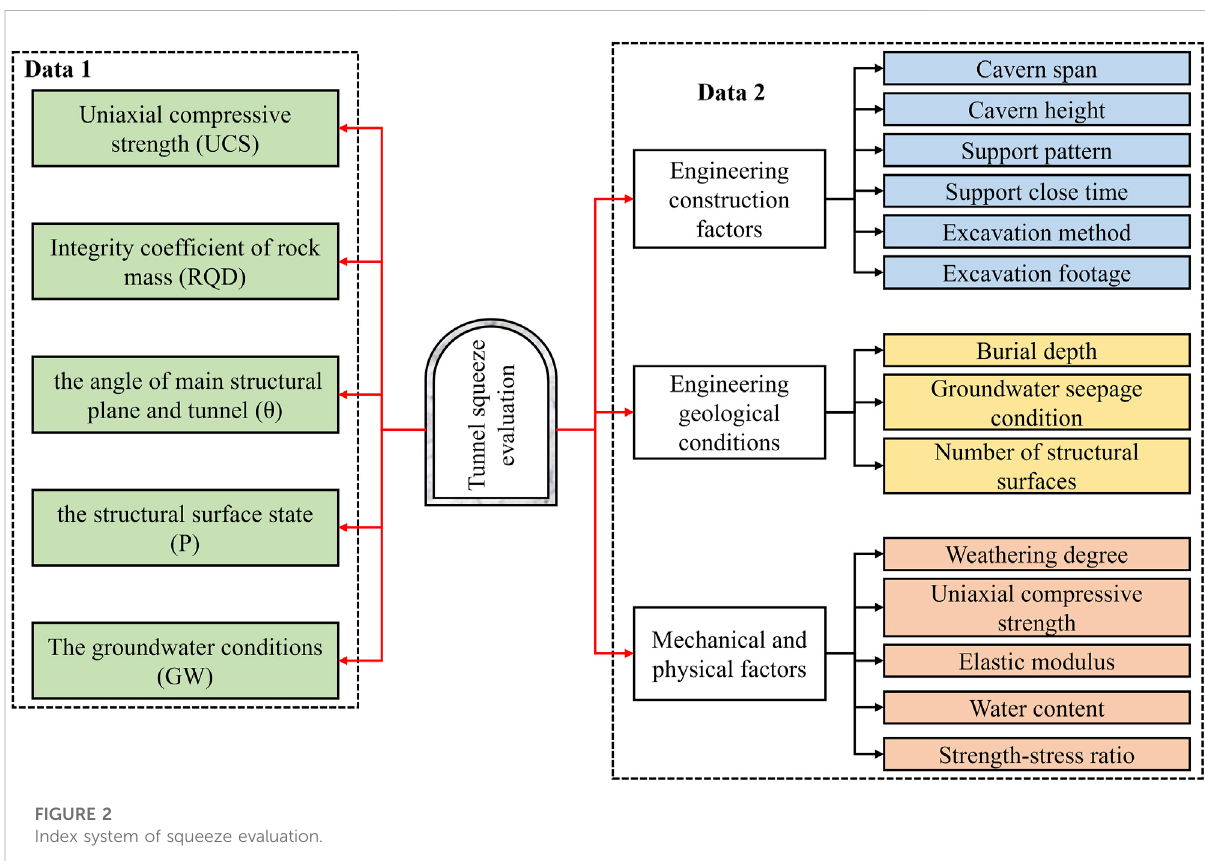
FIGURE 2 Index system of squeeze